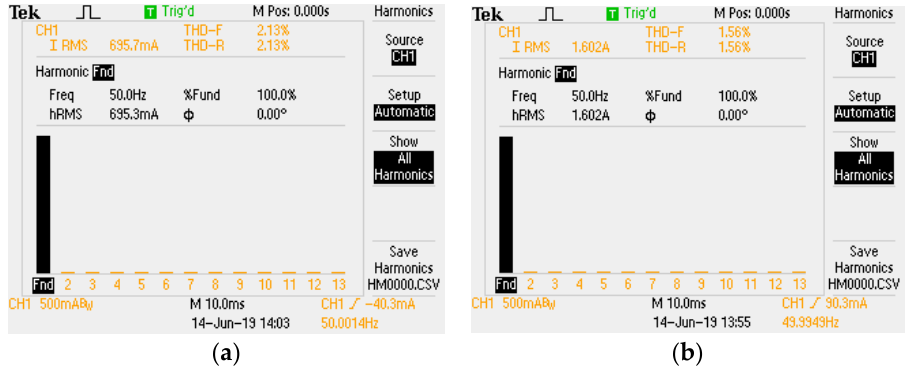
Figure 10. The load current fast Fourier transform (FFT) and its THD. ( a ) m = 0.4 and ( b ) m =